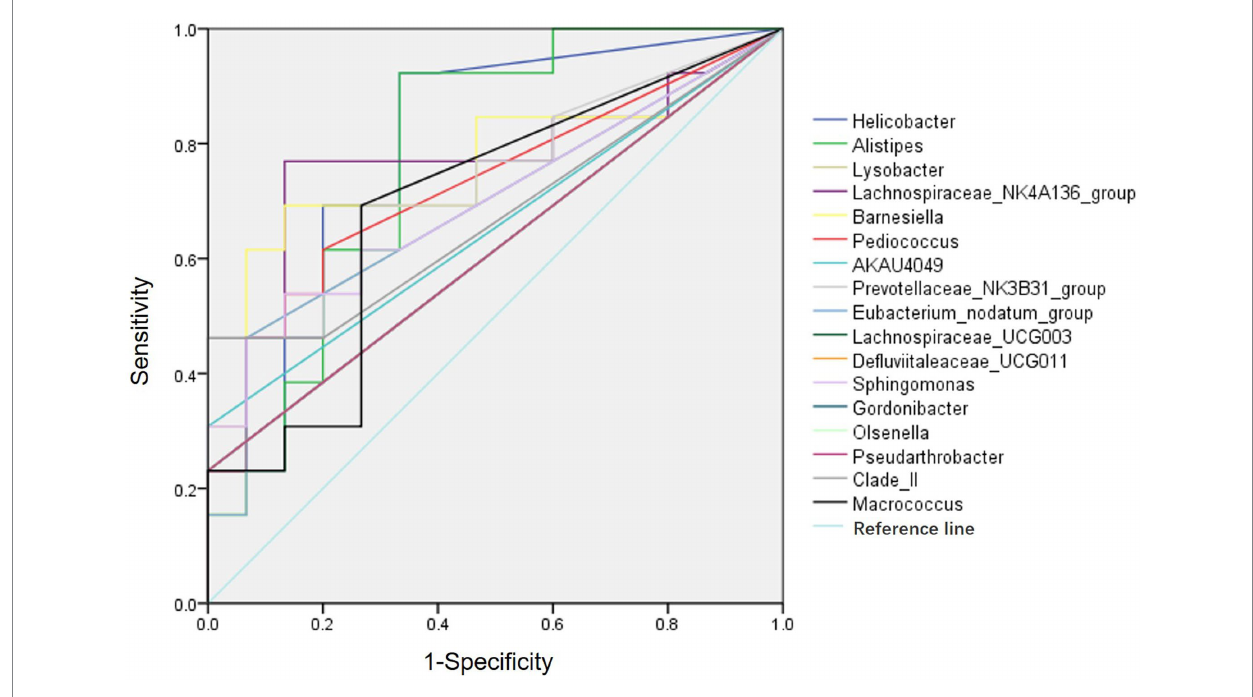
FIGURE 3 ROC curves of the gut genus bacterium relative abundance for the diagnosis of POCD. Vertical coordinate indicated the sensitivity of diagnosis, horizontal coordinate indicated the 1-specificity of diagnosis, AUC > 0.5 indicated a diagnosis efficiency of the gut bacterium.